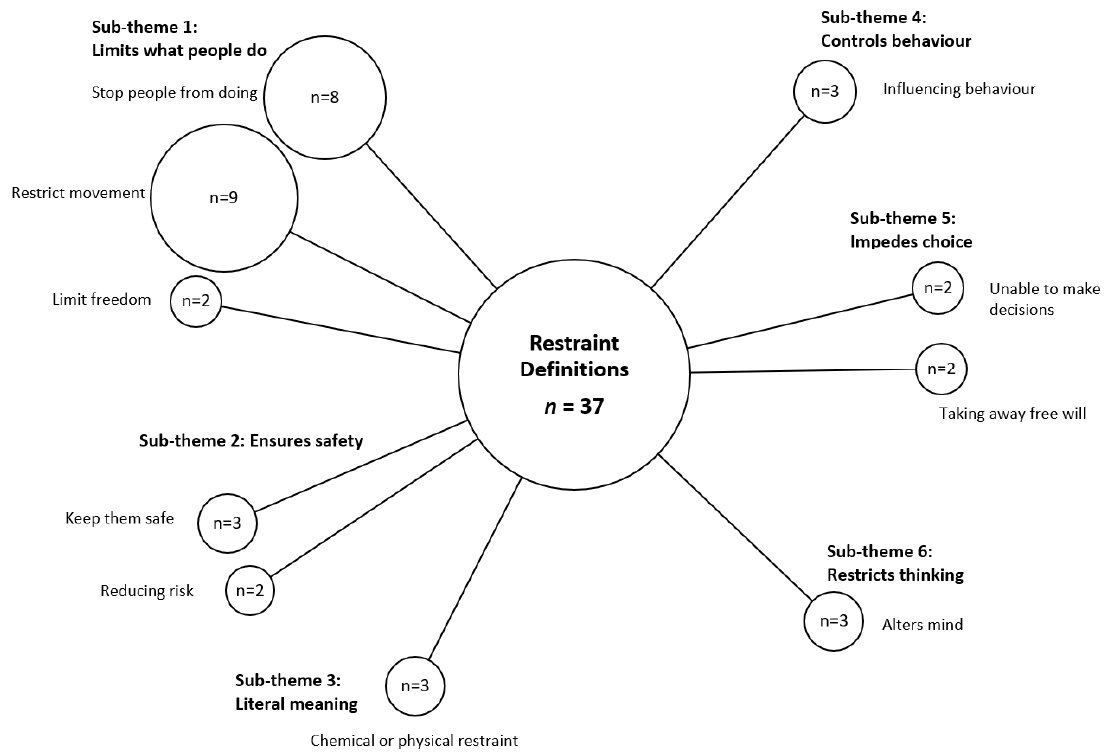
Figure 1. Codes and Sub-themes relating to participants’ understanding of restraint. n = number of definitions.